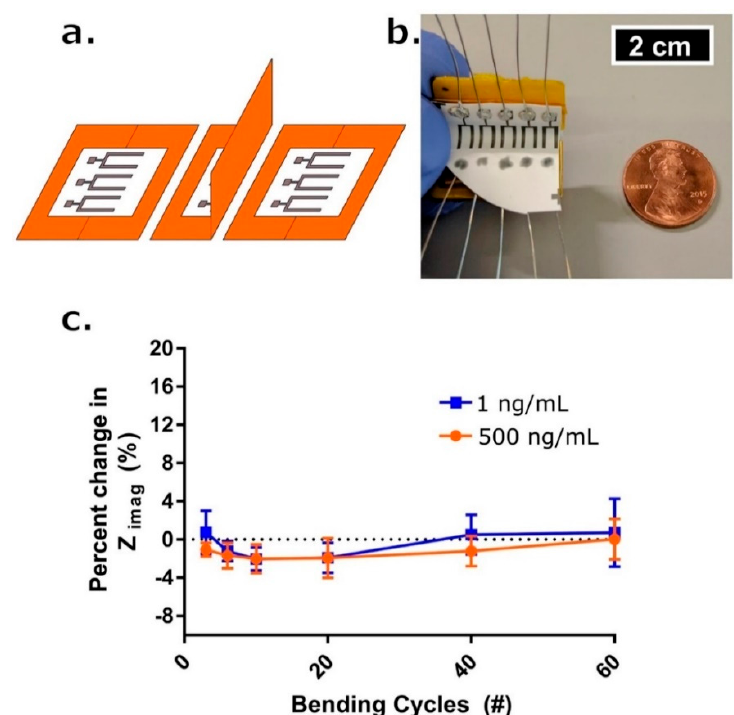
Figure 6. ( a ) Schematic drawing for one complete bending cycle of the sensor. The cycle is comprised of (left) unbent state, (middle) 90° flexion motion bend, and (right) return to unbent state at which point a measurement occurs. ( b ) Picture of bending apparatus with an affixed sensor array affixed. Penny for reference. ( c ) Percent change in Zimag impedance with respect to the initial measurement post-cortisol dosing and 7-min incubation time (blue box—1 ng/mL, red circle—500 ng/mL) after # of bending cycles ( n = 3). Error bars are standard error of the mean. Reproduced from [144] with permission from Springer Nature Limited.